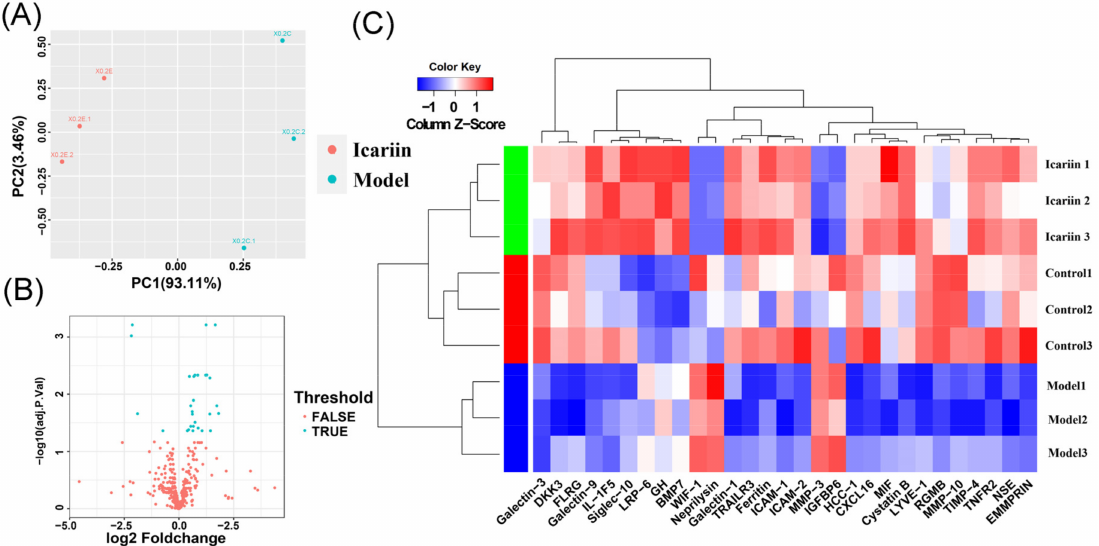
Figure 3. ( A ) Principal component analysis of different samples; ( B ) a volcano plot of identified protein in EVs isolated from BMECs in the Icarrin-treated group and the Model group. The blue dots represent DEPs (|FC| > 1.2 and adj. p . value < 0.05), the red dots represent proteins without significant difference. There were 25 differentially upregulated genes and 4 differentially downreg- ulated genes; and ( C ) a heatmap of 29 differentially expressed proteins between the Icariin-treated group and the Model group. Hierarchical clustering analysis of z-scored FPKM was performed for each DEPs and the color scale represents FPKM normalized log10 transformed counts. Horizontal bars represent genes and the vertical column represents samples. Red color represents differentially upregulated genes, while blue color indicates differentially downregulated genes.